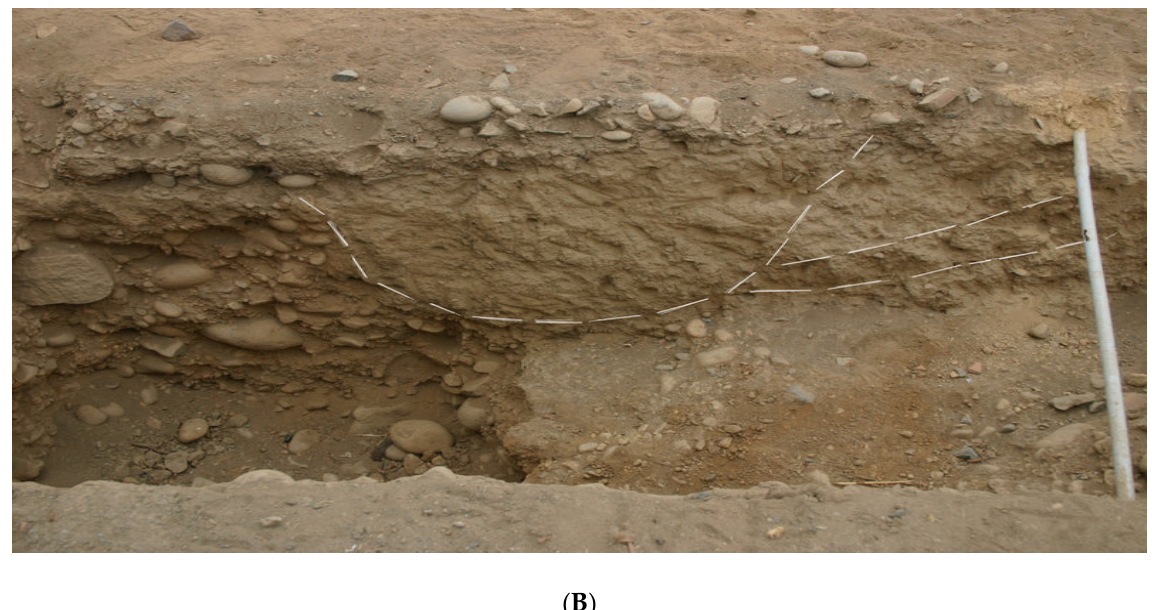
Figure 3. ( A ) Caral site map. Note the proposed internal site canal (red line) in the region between the upper north and lower south areas based upon the canal profile data taken next to the Caral excavation house in the Residential Area. ( B ) Continuation Excavated canal cross-section profiles taken at the leftmost red-line canal extension Residential Area shown in Figure 3A thought to exist between the upper and lower regions of Caral.